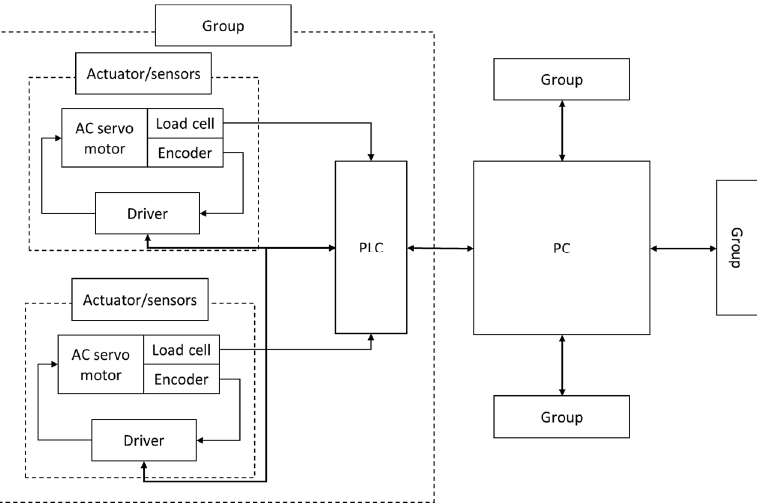
Figure 24. Diagram of the control system of our proposed prototype.